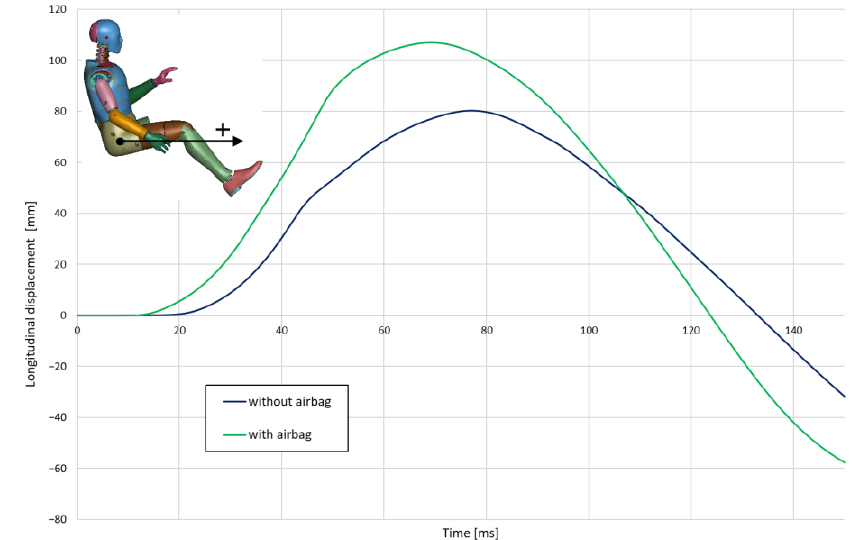
Figure 5. Longitudinal displacement of H-point.